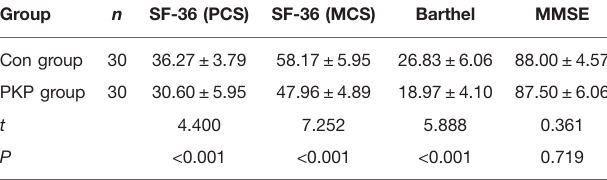
TABLE 3 | Comparison of other clinical outcomes at 6 months post-treatment between two groups.